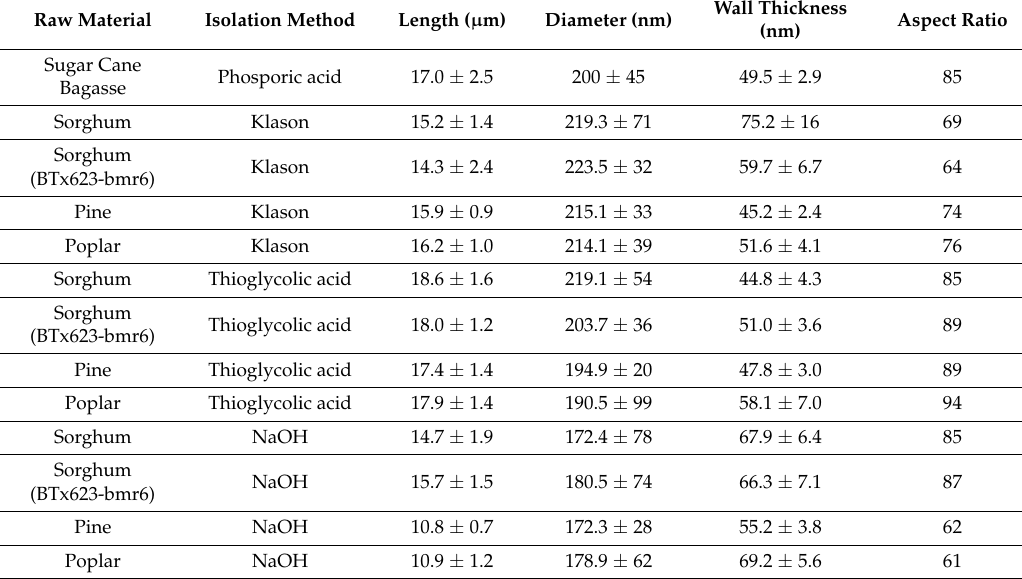
Table 1. Morphology results from SEM imaging showing length, diameter, wall thickness and aspect ratio of nanotubes made of lignin from different raw materials and different isolation methods. Adapted with permission from from Ten et al. [101]. Copyright 2014 American Chemical